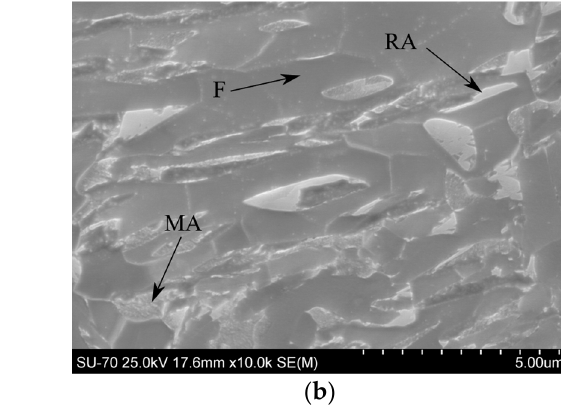
Figure 6. SEM micrographs of the as-received CR980XG3 TM steel sheet with ( a ) 1000× and ( b ) 10,000× highlighting the ferrite (F), martensite–austenite (MA), and retained austenite (RA). The X-ray diffractogram of the CR980XG3 TM steel for the as-received condition is shown in Figure 7, in which the peaks are identified as α -iron or γ -iron.